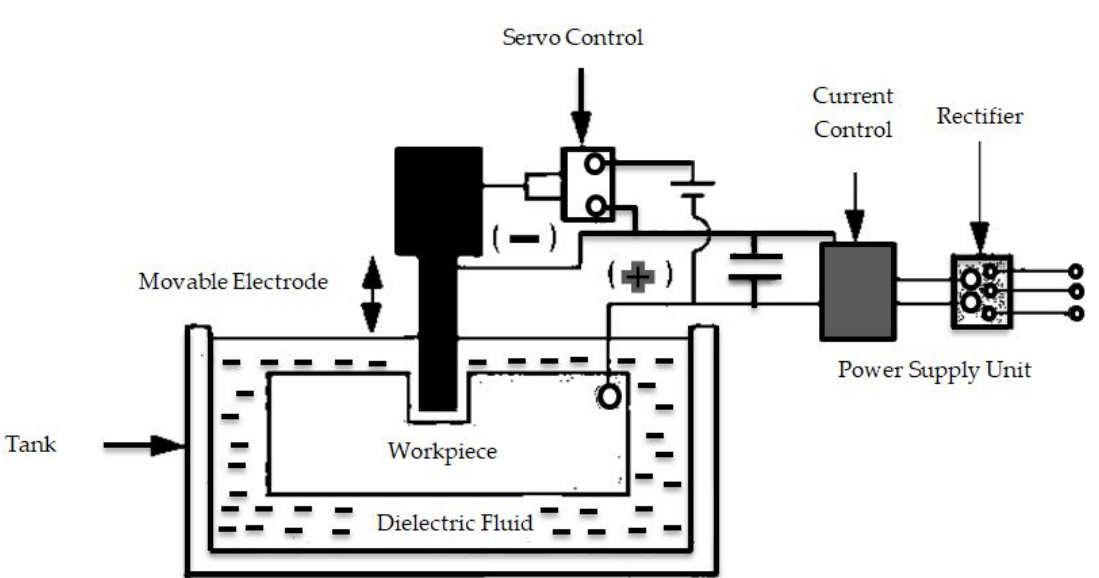
Figure 1. Schematic representation of the basic working principle of electrical discharge machining (EDM) process.